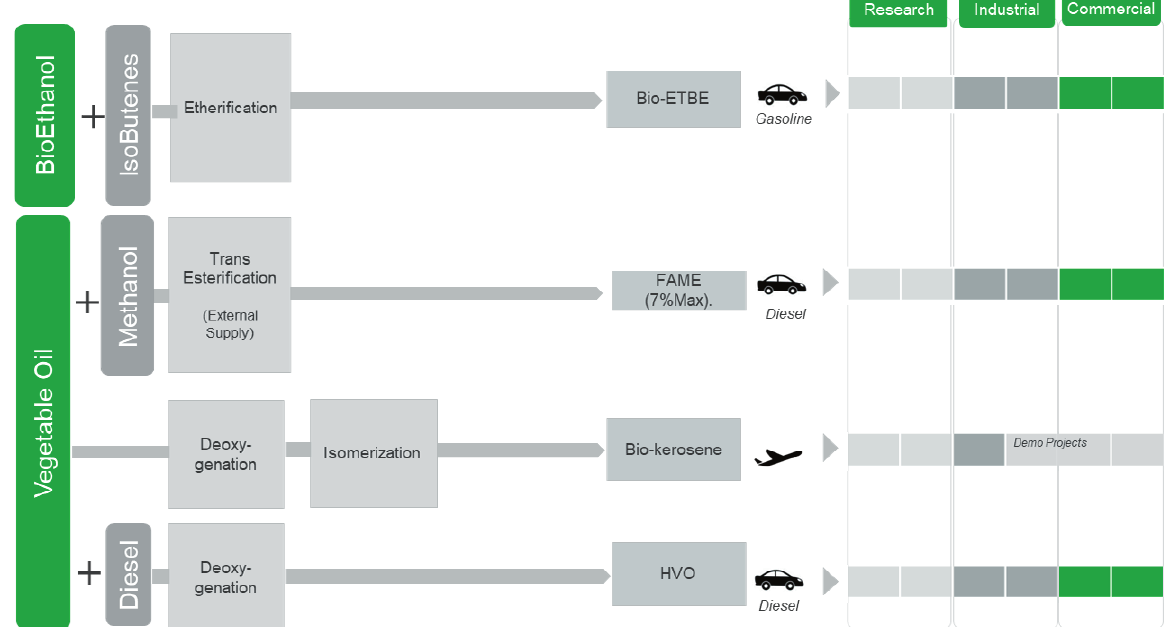
Figure 9. Biofuels production in